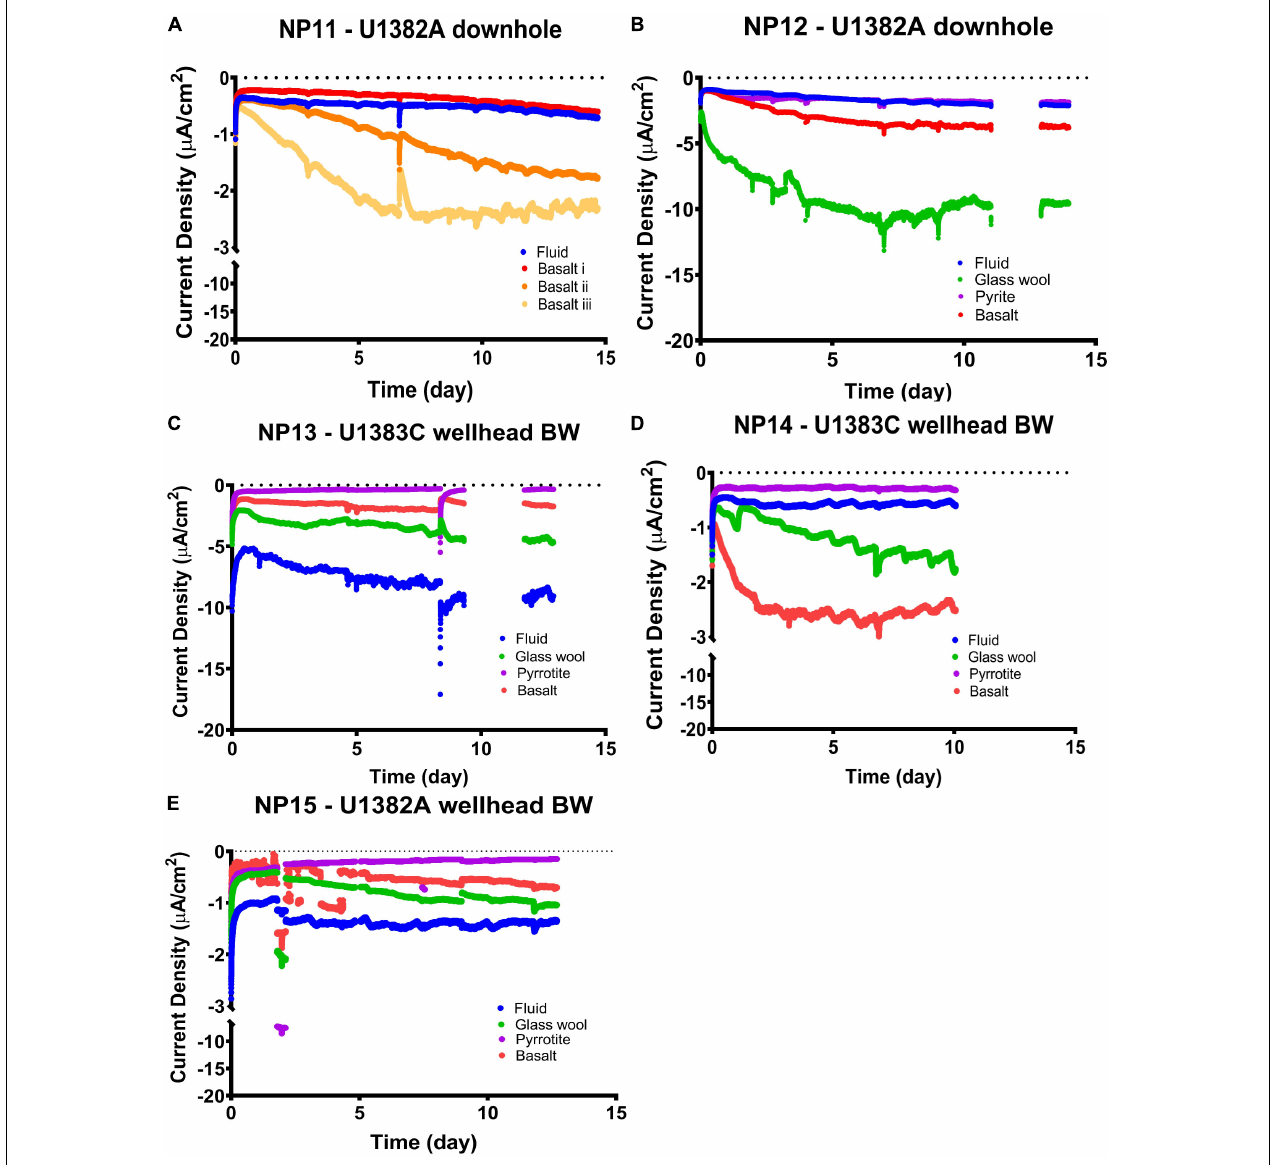
FIGURE 3 | Chronoamperometry profiles of current (normalized to electrode surface area) versus incubation time in cathodic poised potential experiments at –200 mV (versus standard hydrogen electrode), with channels and conditions as listed as in Tables 1 , 2 . (A) NP11, (B) NP12, (C) NP13, (D) NP14, and (E) NP15. Breaks in data records indicate periods when data were not recorded due to glitches in software. Note the breaks in the y -axes in the NP11, NP14, and NP15 experiments, and that ‘-’ here denotes current direction and not mathematical negative so increasingly negative values represent increasing current density of the electron flow direction out of the